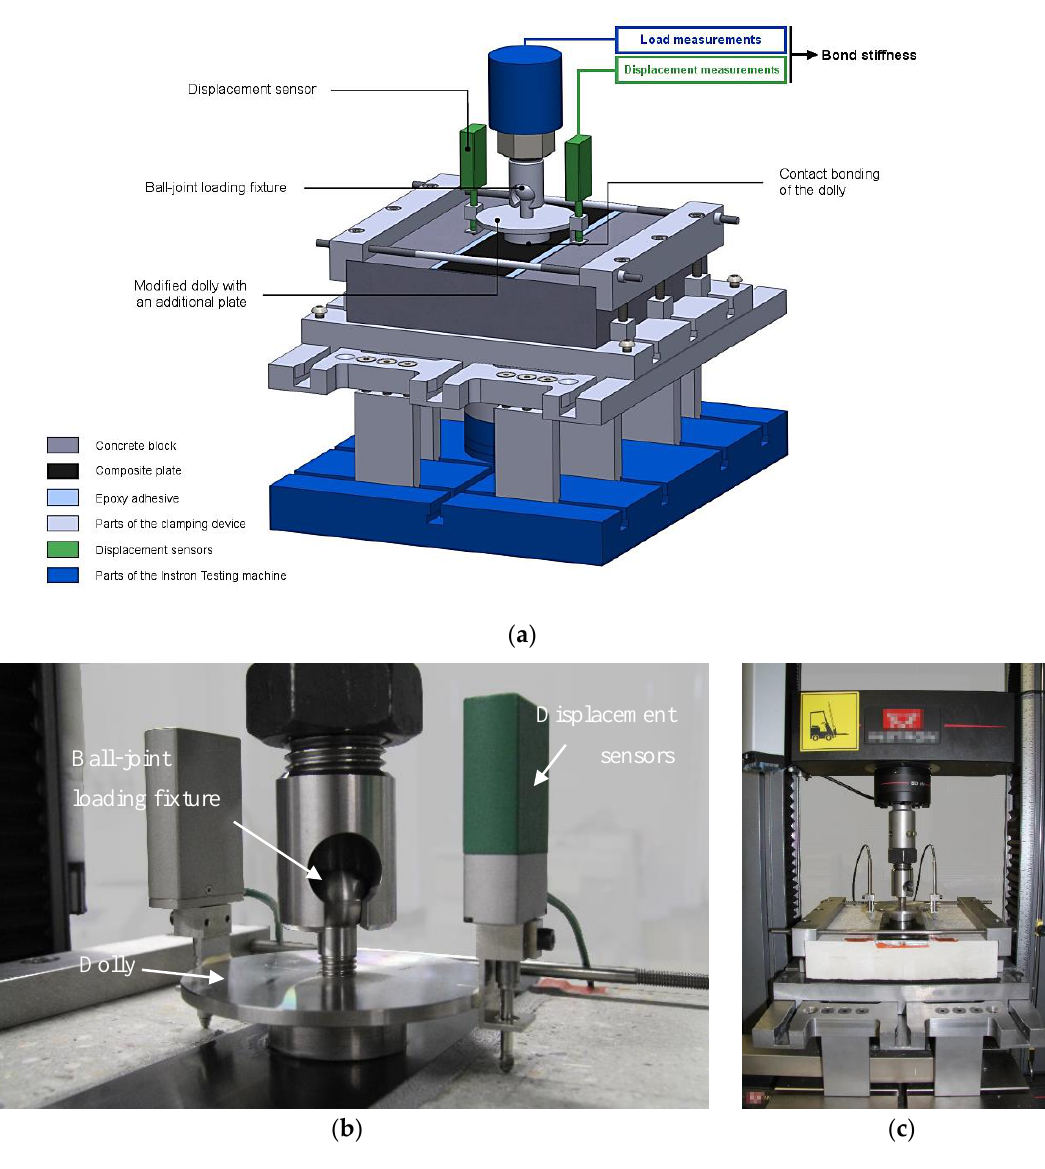
Figure 3. Modified ND pull-off test: ( a ) schematic view of a CFRP reinforced concrete specimen installed in the clamping device; ( b ) ball-joint loading fixture and displacement sensors fixed to the dolly; ( c ) clamping device installed on the testing machine.